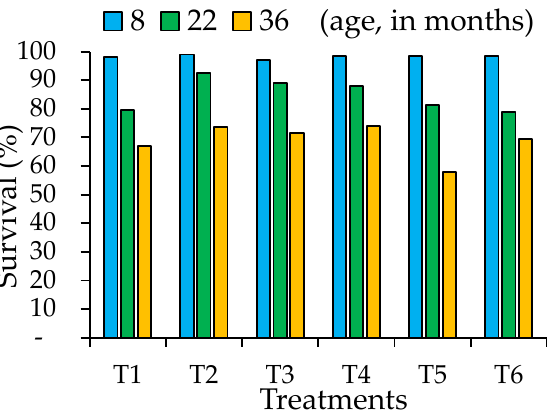
Figure 3. Survival (%) of trees of paricá at 8, 22, and 36 months of age, submitted to soil management practices.